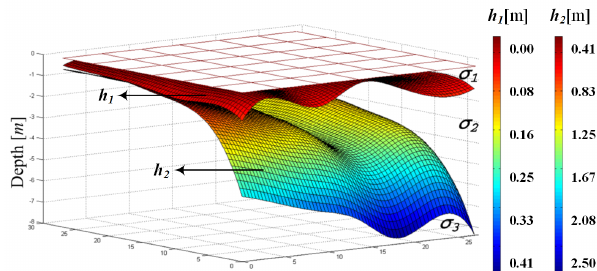
Figure 22. View of 3D mapping for profile of